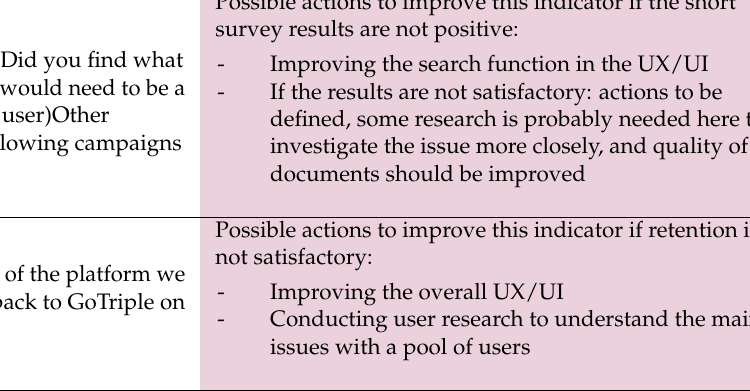
4th category: Indicators on Quality (Retention) “User experience